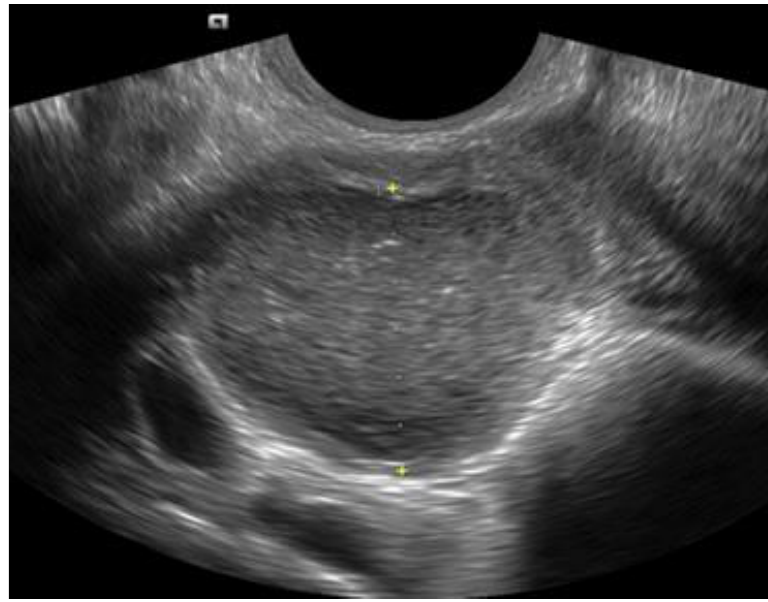
Figure 1. Typical ovarian endometrioma (OMA) with a ground-glass appearance.